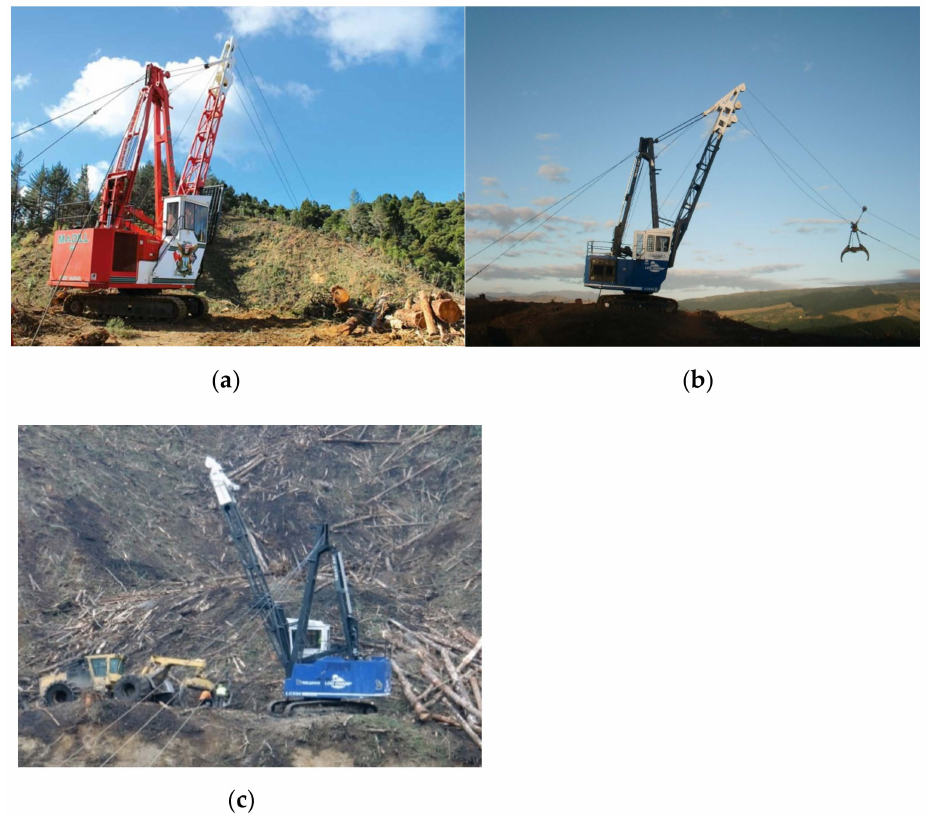
Figure 1. ( a ) Madill 124 ( b ) T-Mar 650 and ( c ) T-Mar 550 swing yarders at the locations of the time studies (CS-1 to CS-3,